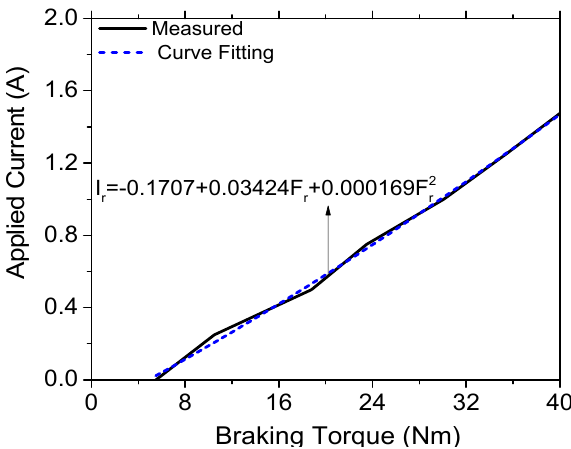
Figure 20. Applied current of the linear brake as a function of force.